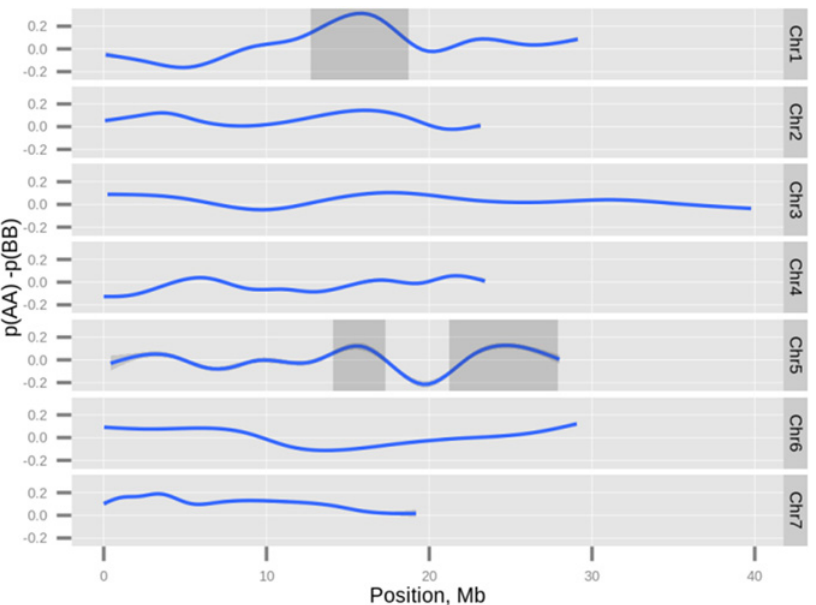
Fig 5. Differential genotype proportion. The proportions of homozygous genotype calls p(AA) and p(BB) were calculated. A spline non-linear regression of p(AA) – p(BB) was plotted against the genome position. The genomic areas of segregation distortion (gray rectangles) were estimated by chi-square test under the null hypothesis that the frequencies of p(AA) and p(BB) were equal. The null hypothesis was rejected at a level of 5% adjusted by Benjamini-Hochberg method for false discovery rate.